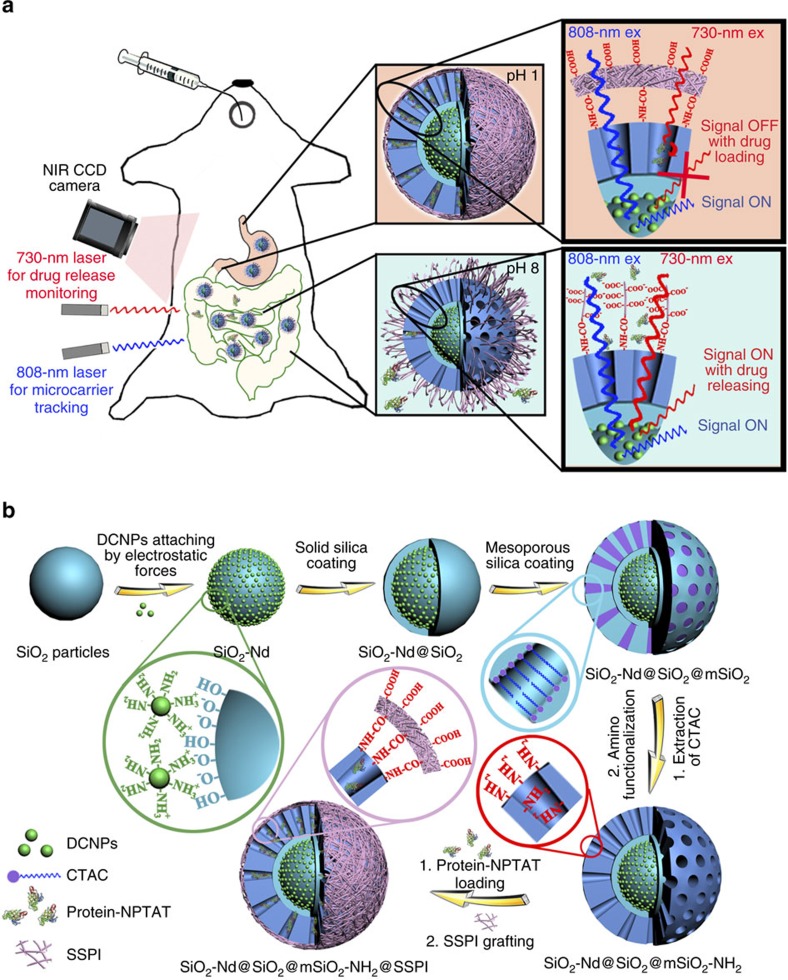
Schematic illustration of the ACIE bioimaging system and fabrication procedure.(a) Microcarrier fate tracking and drug-release monitoring by the ACIE bioimaging system using an InGaAs CCD camera. After oral administration, the BSA–NPTAT-loaded microcarriers showed little protein drugs leakage in the GI tract (pH=1) but sustained release in the intestine (pH=8) due to the deprotonation of the SSPI on the outer surface of the microcarrier. (b) Procedures of NIR-II fluorescent mesoporous microcarriers preparation, protein drugs loading and SSPI grafting.